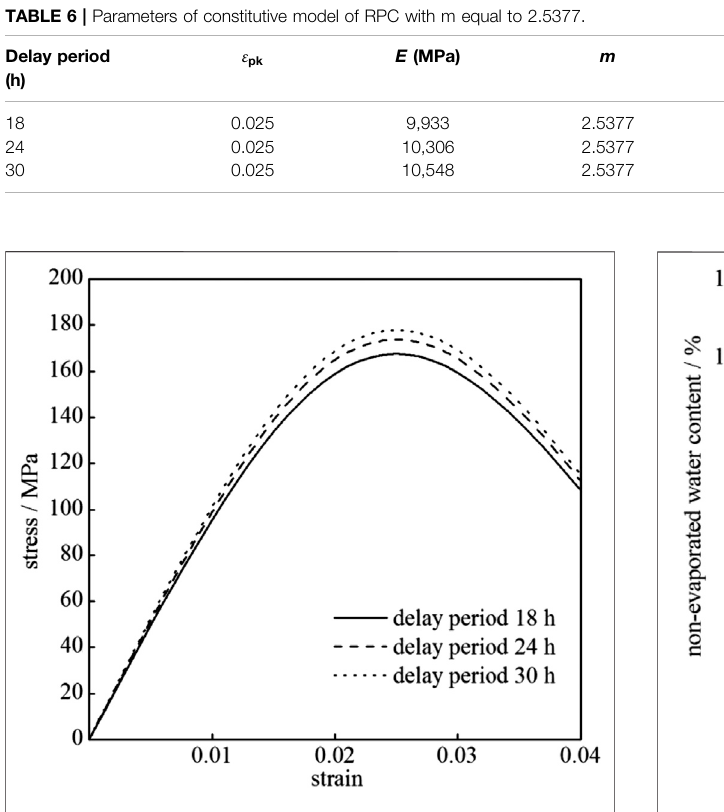
Figure6| ConstitutivemodelcurvesofRPCunderdifferentdelayperiod. Figure 7 | The amount of non-evaporated water in the paste at different